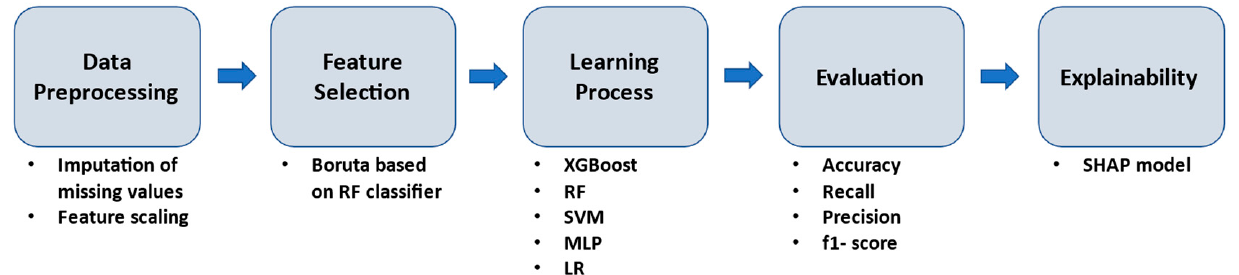
Figure 1. Workflow of the proposed methodology.